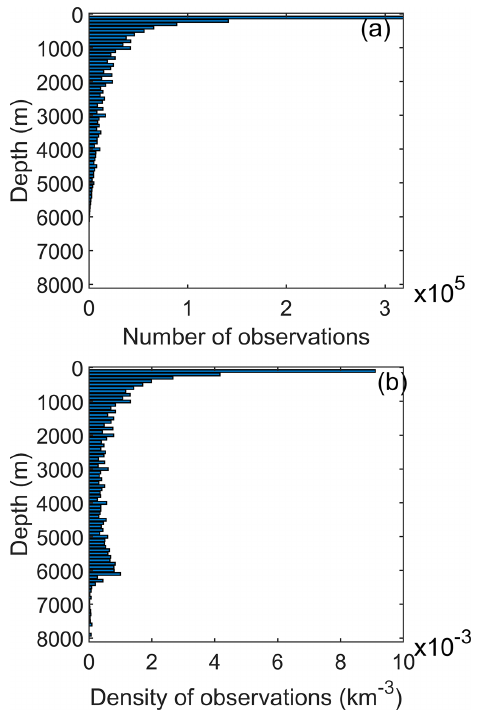
Figure 11. Number (a) and density (b) of observations in 100m depth layers. The latter was calculated by dividing the number of observations in each layer by its global volume calculated from ETOPO2 (National Geophysical Data Center, 2006). For example, in the layer between 0 and 100m there are on average 0.0075 obser- vations per cubic kilometer. One observation is one water sampling point and has data for several